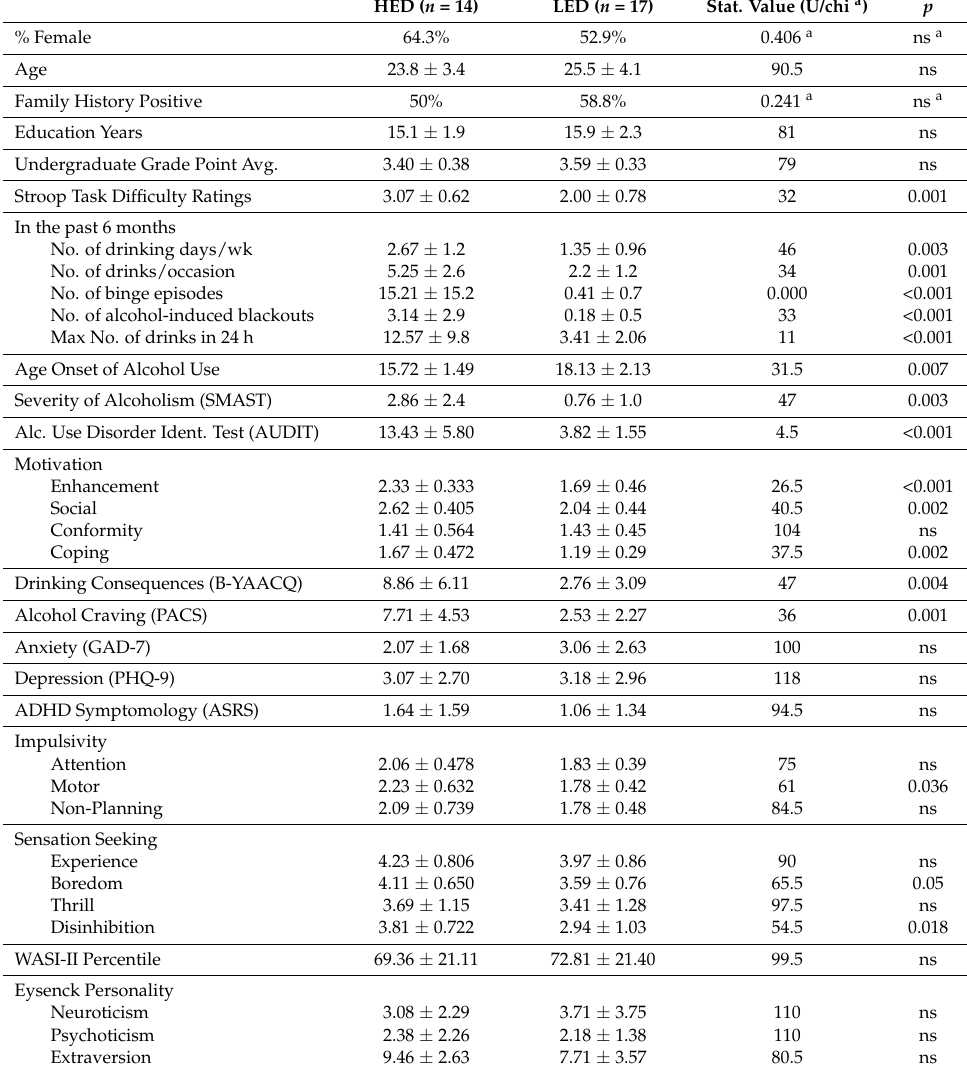
Table 1. Subjects characteristics (mean ± SD or n (%)) for heavy (HED) and light episodic drinking (LED)